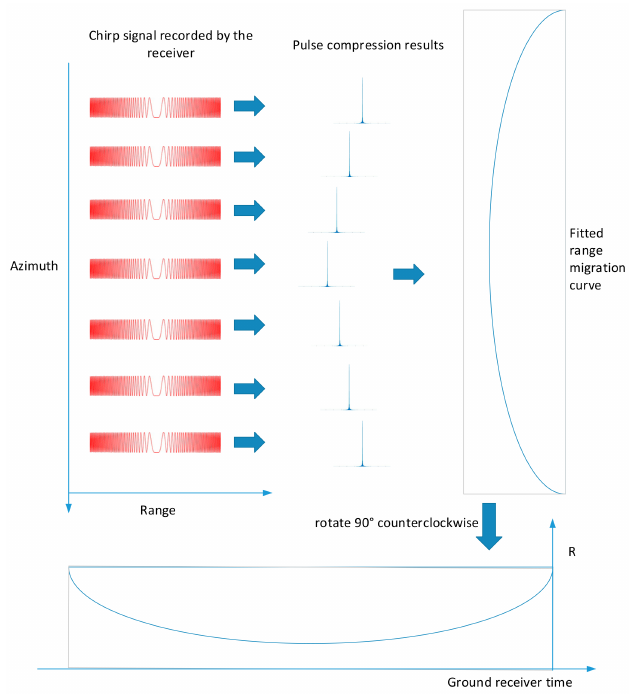
Figure 5. Range migration information extraction